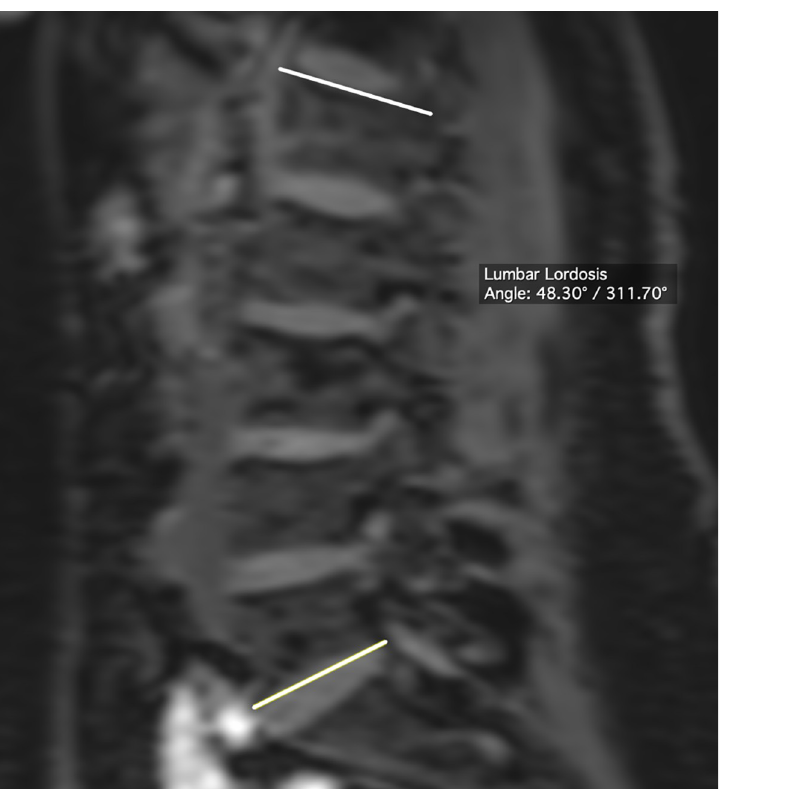
Fig 2. Measurement of lumbar lordosis.